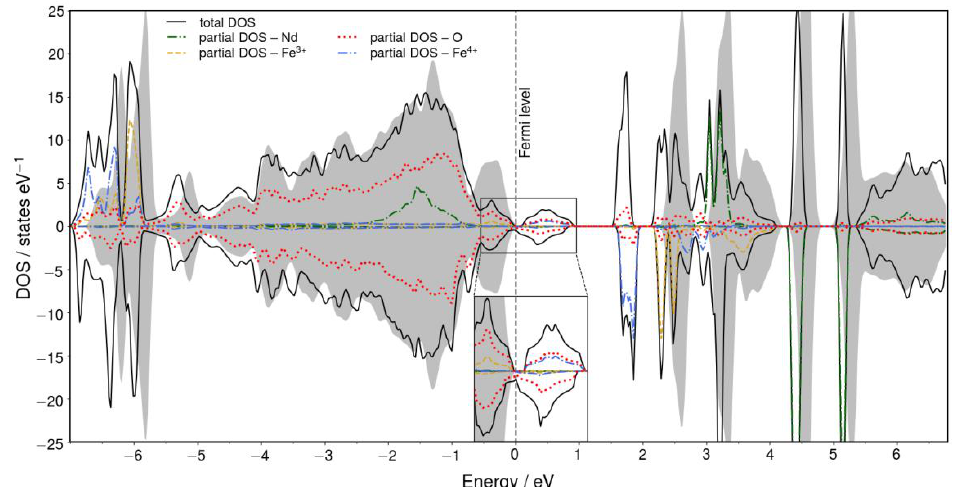
Figure 3. Total (black solid line) and partial (dashed colored lines) DOS for Nd 0.5 Ca 0.5 FeO 3 . The dashed vertical line represents the Fermi level. The total DOS of bulk NdFeO 3 is included for reference as grey area. The inset focuses on the DOS around the Fermi level. For Nd, Fe 3 + , and Fe 4 + the partial DOS is shown only for one spin, the antiferromagnetic counterparts are omitted.